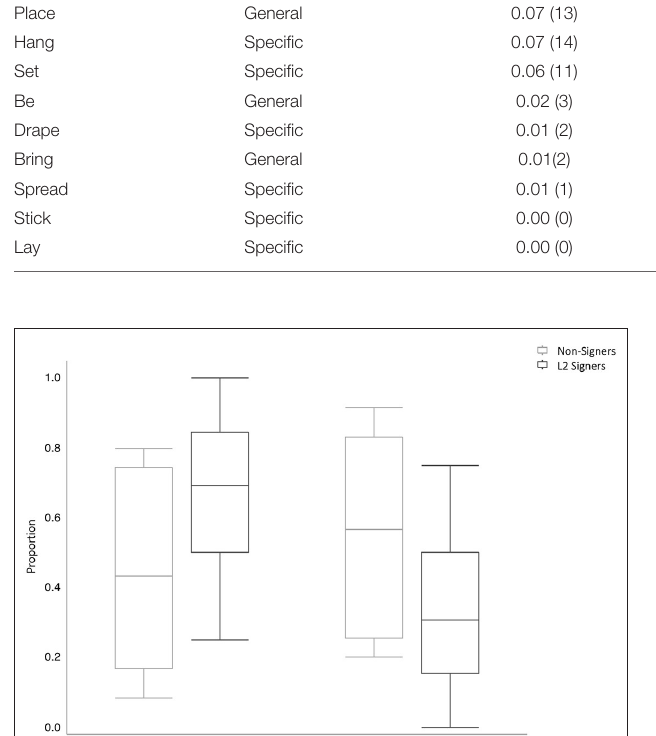
FIGURE 6 | Proportion gesture type in English by